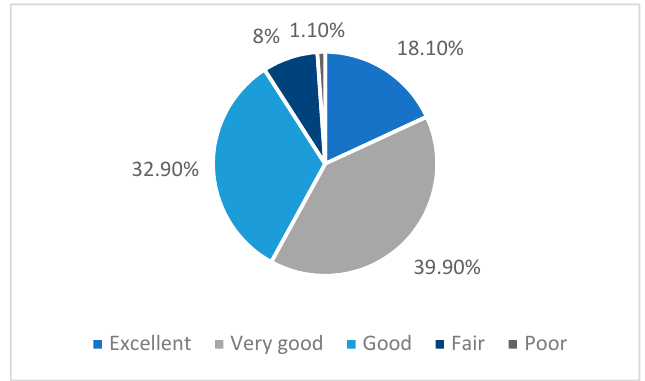
Figure 2. Perceived health during the COVID-19 pandemic .